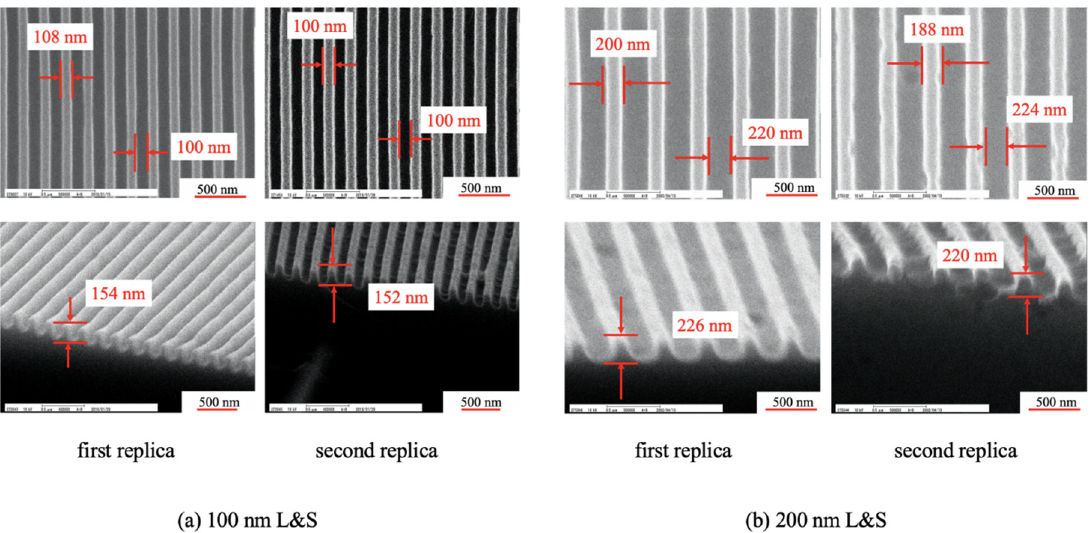
Figure 8. SEM images of the ( a ) 100 nm L&S and ( b ) 200 nm L&S transferred patterns.